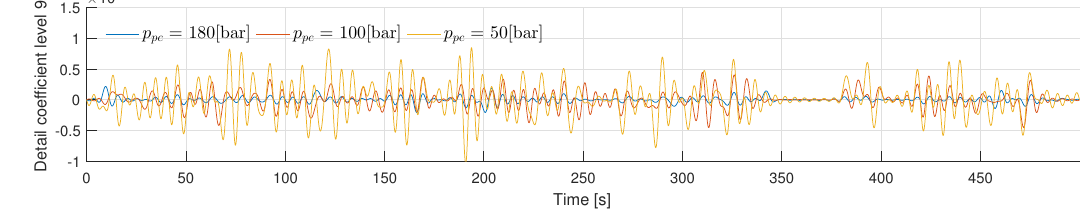
Figure 7. Detail coefficient decomposition Level 9 for three levels of pre-charge pressure in the nominal operating condition. Decomposed using the fifth order Daubechies mother wavelet.